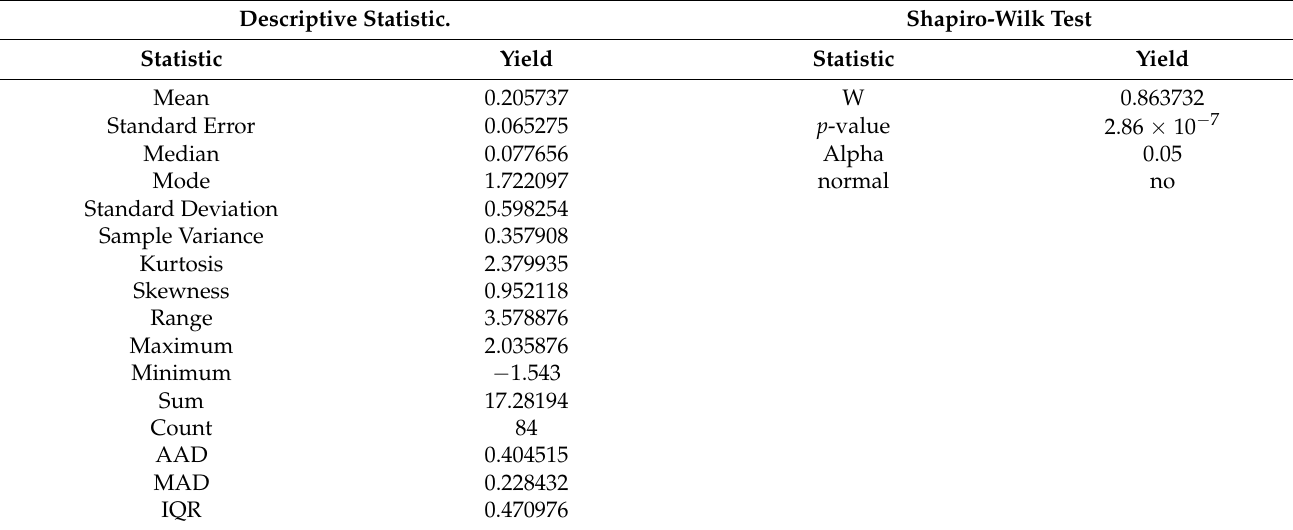
Table A6. Descriptive Statistics yields on sovereign bond (Source: Authors). Descriptive